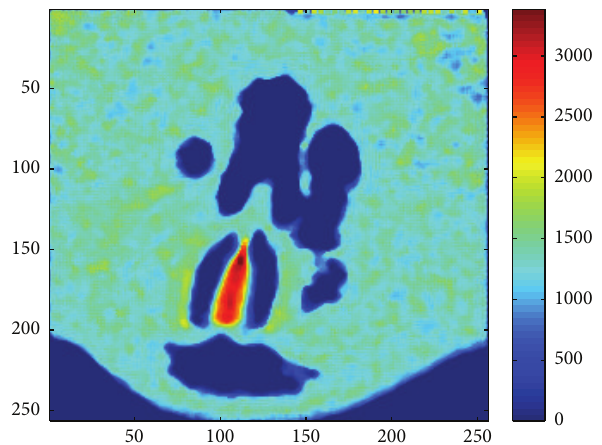
Figure 4: TV-image obtained from 300 frames.